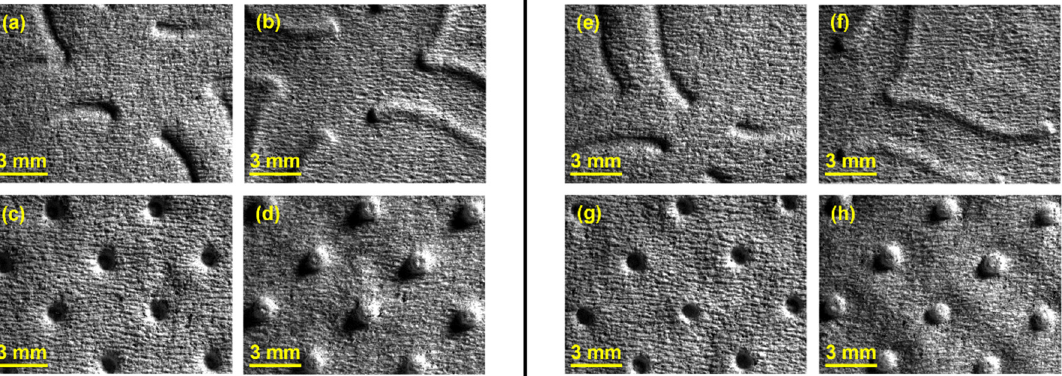
Figure 13. Global views of tissue paper embossed with the different combinations of rubber hardness